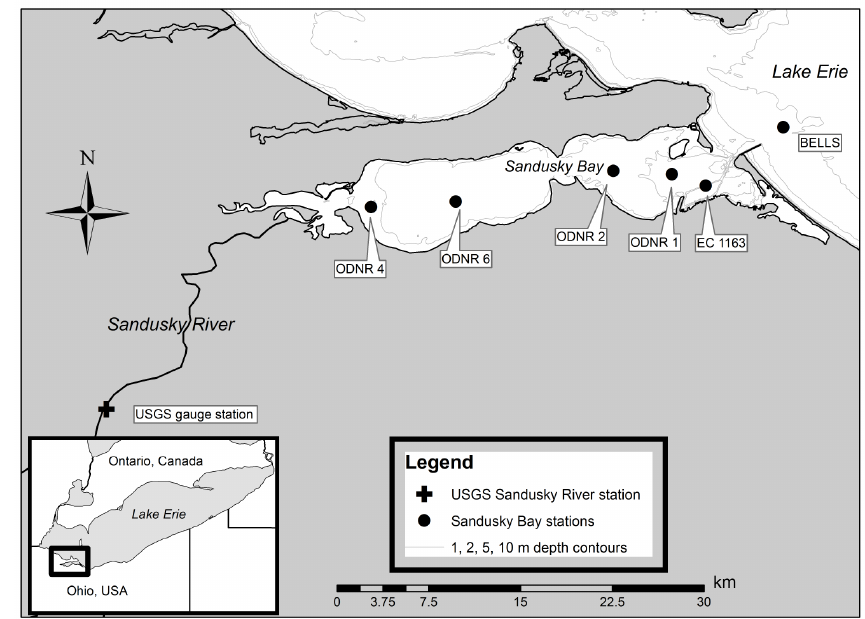
Figure 1. Sampling locations in Sandusky Bay (circles) and Sandusky River monitoring station (USGS monitoring station 04198000,